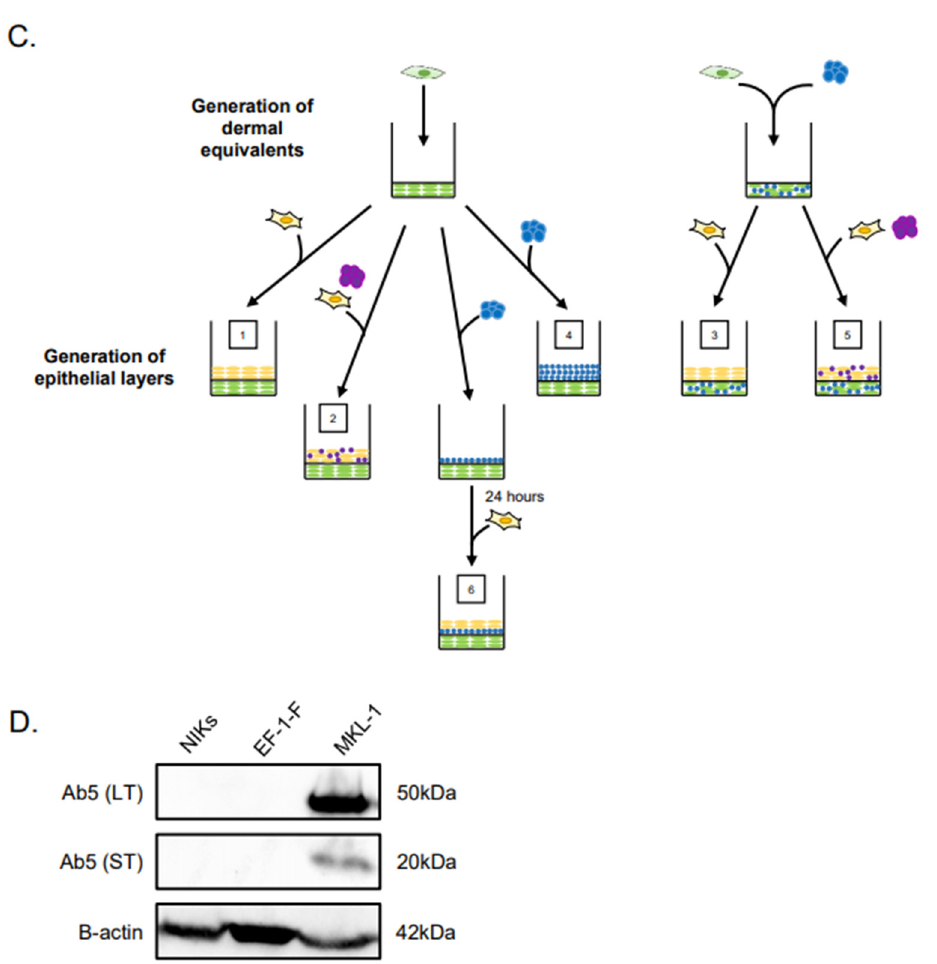
Figure 1. Experimental design of Merkel cell polyomavirus–positive (MCPyV+) Merkel cell carcinoma (MCC) culture in organotypic rafts. ( A ) General workflow and timeline of 3D organotypic raft co-culture with MCPyV+ MCC. Rafts were harvested at the endpoint using the process depicted; paraffin-embedded and 5 µ M-thick sections were cut from a paraffin block and laid onto slides for hematoxylin and eosin (H&E) and immunostaining analyses. ( B ) Experimental organization/setups of rafts generated. The six conditions tested are depicted. Cell types included in the various raft setups include NIKS keratinocytes (yellow), early passage human foreskin fibroblasts (EF-1-F) fibroblasts (green), MCPyV+ MCC cells without collagen (purple), and MCPyV+ MCC cells in collagen (blue). ( C ) Experimental workflow for each raft setup depicted in ( B ). Dermal equivalents were generated with either EF-1-F or EF-1-F/MKL-1 mix and left to culture for 4–7 days. The epithelial layer was then generated by layering NIKS epithelial cells or epithelial cells with MKL-1 cells. For Setup 4, MKL-1 cells were suspended in collagen and added to the dermal equivalent. For Setup 6, an intermediate layer of MKL-1 cells in collagen was added and allowed to settle for 24 h, followed by the addition of NIKS keratinocytes. ( D ) Immunoblot analysis for the MCPyV large T antigen (LT) and small T antigen (ST) proteins in cell types used in raft studies. Protein lysates from NIKS keratinocytes, EF-1-F fibroblasts, and the MCPyV+ MCC cell line MKL-1 were analyzed by immunoblotting with the Ab5 mouse monoclonal antibody. An immunoblot for β -actin was included as a loading